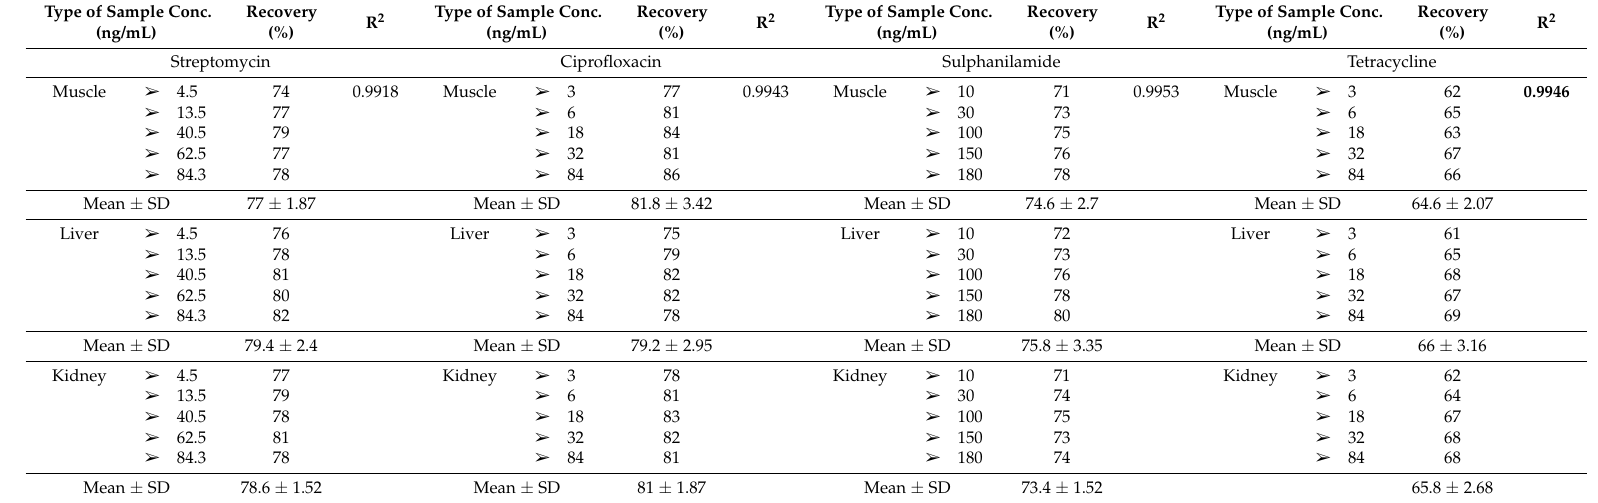
Table 3. Recovery level of spiked organs: muscle, liver, and